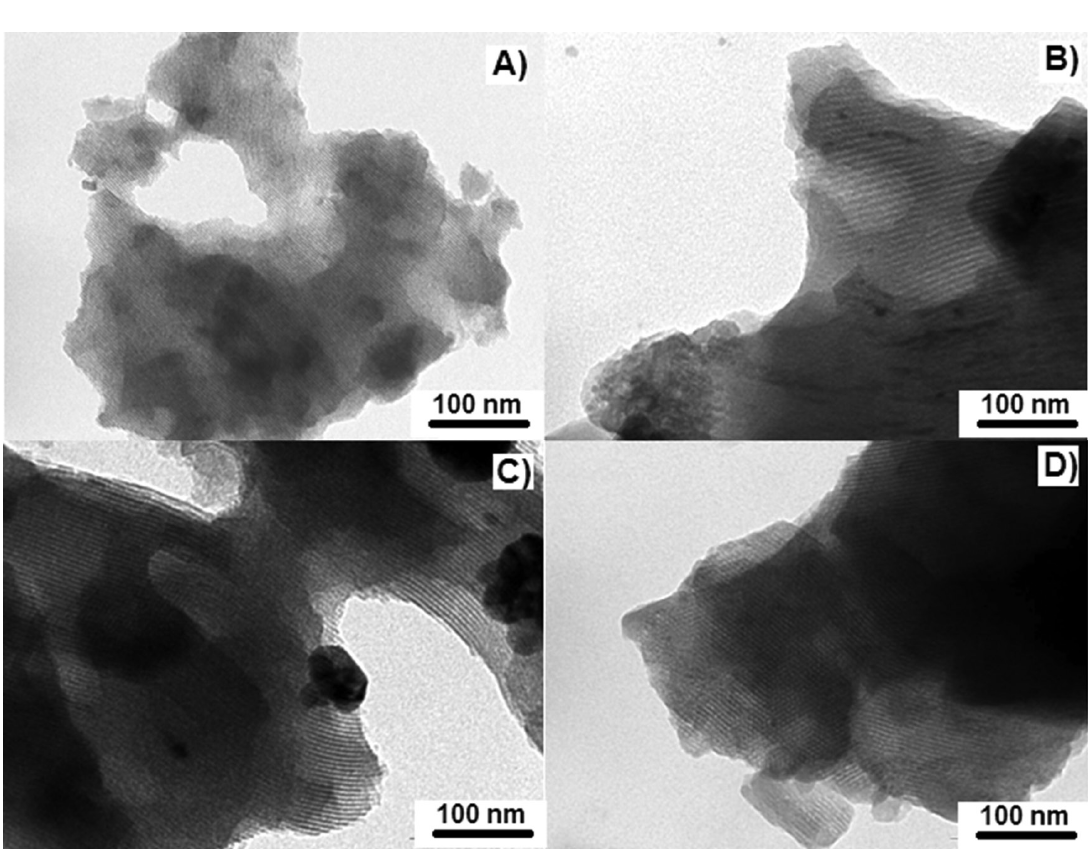
Figure 4. TEM images of mesoporous materials: (a) MCM‑41, (b) NiO/MCM‑41, (c) PdO/MCM‑41 and (d) TiO